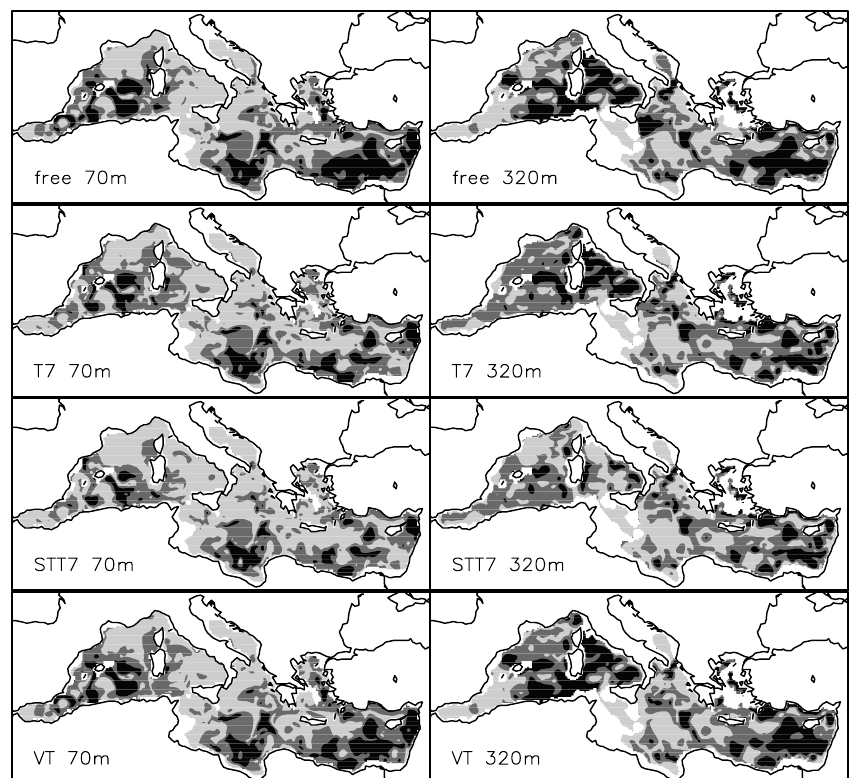
Time-averaged (days 21– 84) error in the winter OSSEs for se- lected sampling strategies and depths. Light grey corresponds to errors less than 0.3 ◦ C at 70m depth and 0.15 ◦ C at 320m; black corresponds to errors greater than 0.6 ◦ C at 70m depth and 0.3 ◦ C at